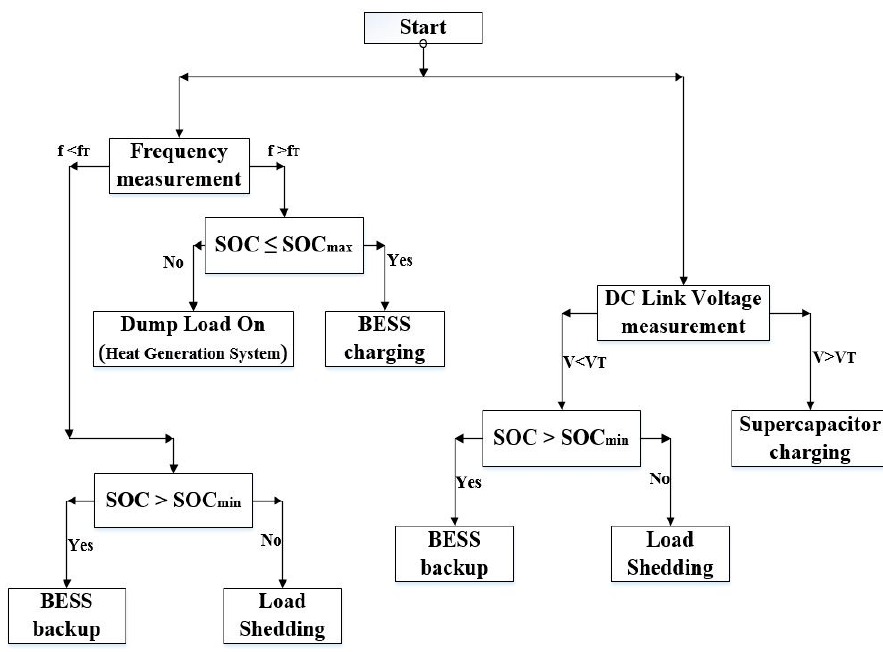
Figure 7 . Flowchart of the proposed control method. Figure 7. Flowchart of the proposed control